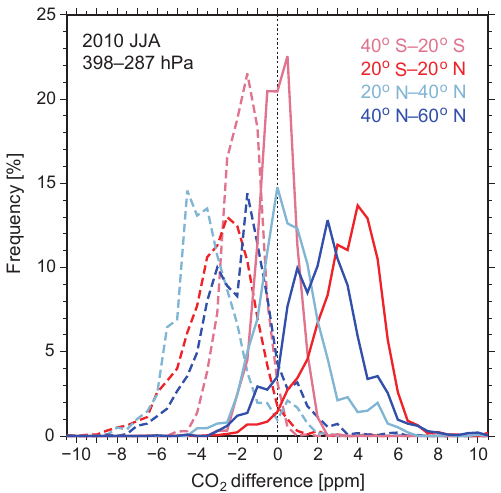
Figure 9. Same as Fig. 7, but showing frequency distributions dur- ing the JJA season of 2010 on 398–287hPa (retrieval layers 7–8) for each latitude band. Pink, red, light blue, and blue lines shows the results from 40–20 ◦ S, 20 ◦ S–20 ◦ N, 20–40 ◦ N, and 40–60 ◦ N,